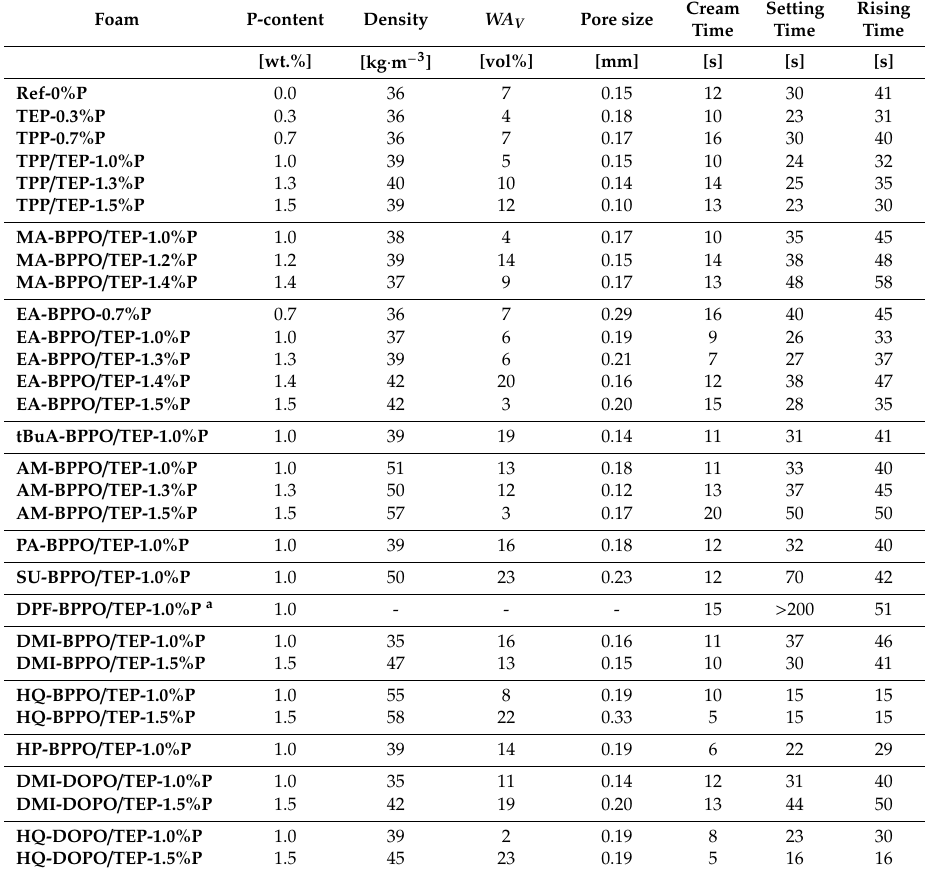
Table 3. Physical properties of the studied foams (description of methods: see Experimental part). Foam P-content Density WA V Pore size